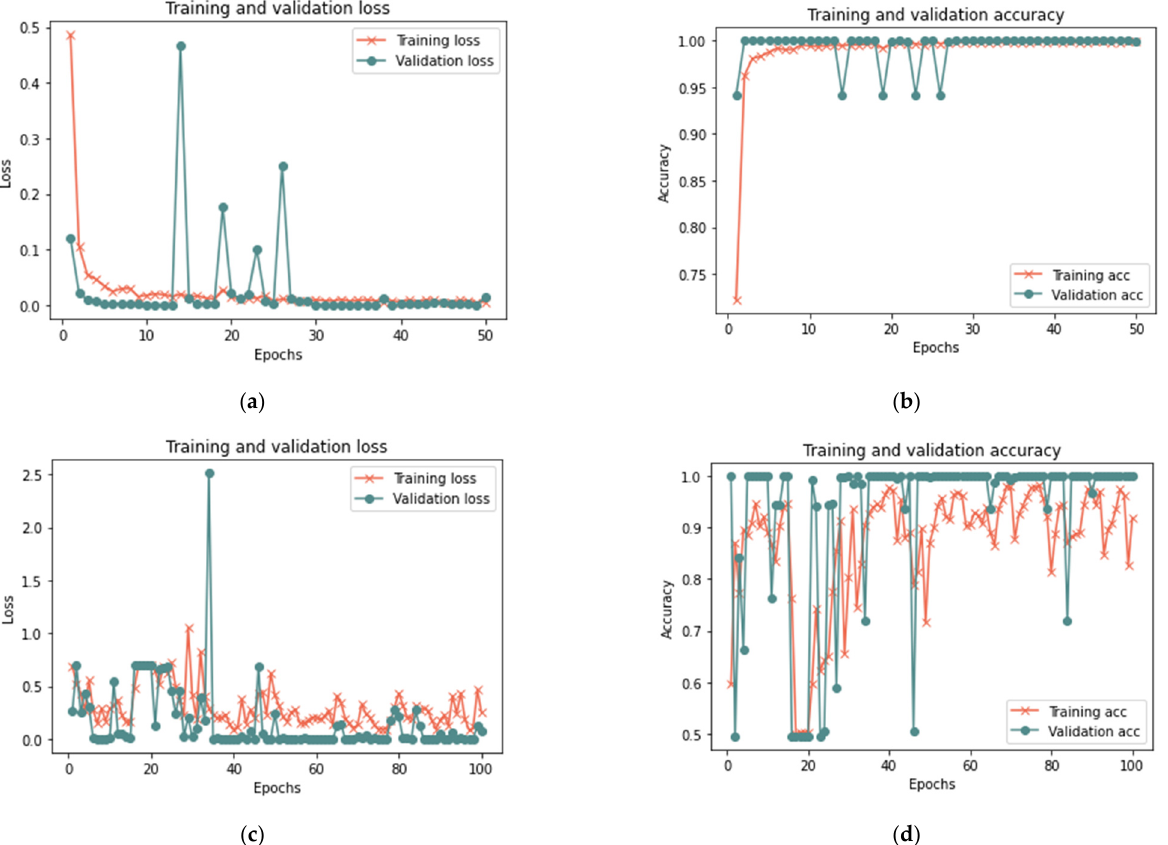
Figure 12. Results of the first scenario with 100% sample size: ( a ) loss at 50 iterations; ( b ) accuracy at 50 iterations; ( c ) loss at 100 iterations; and ( d ) accuracy at 100 iterations.